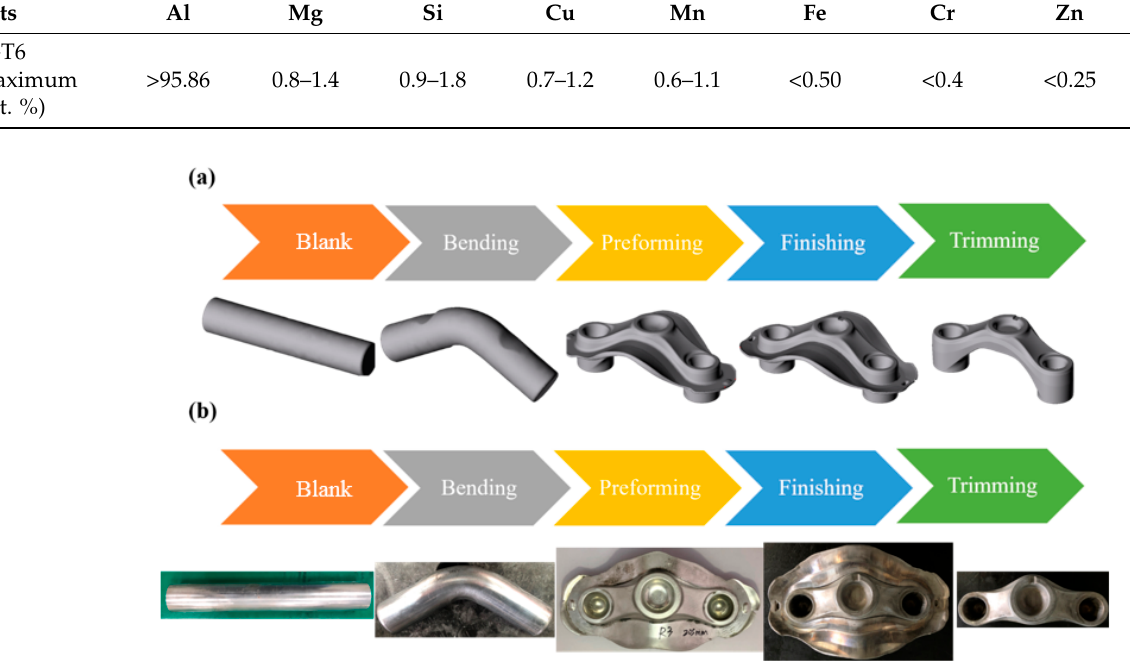
Table 1. Chemical composition of the material.